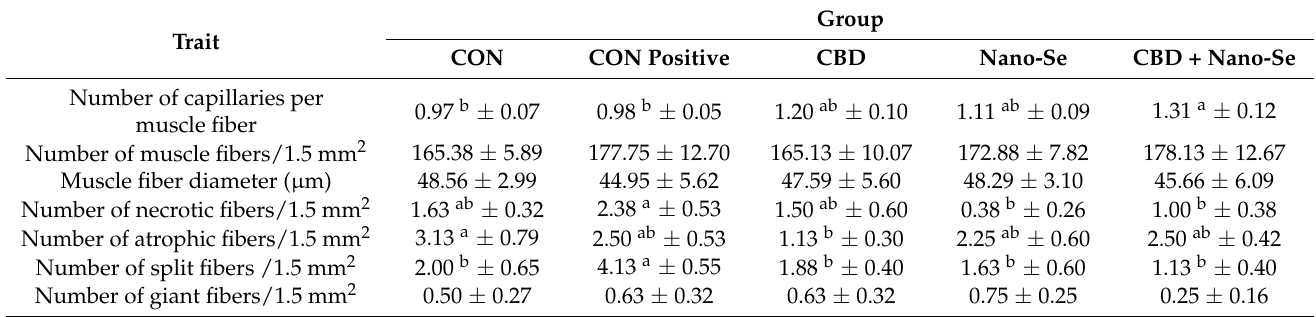
Table 1. Effects of dietary treatments and Clostridium perfringens challenge on the microstructure of the superficial breast muscle in 35-day-old broiler